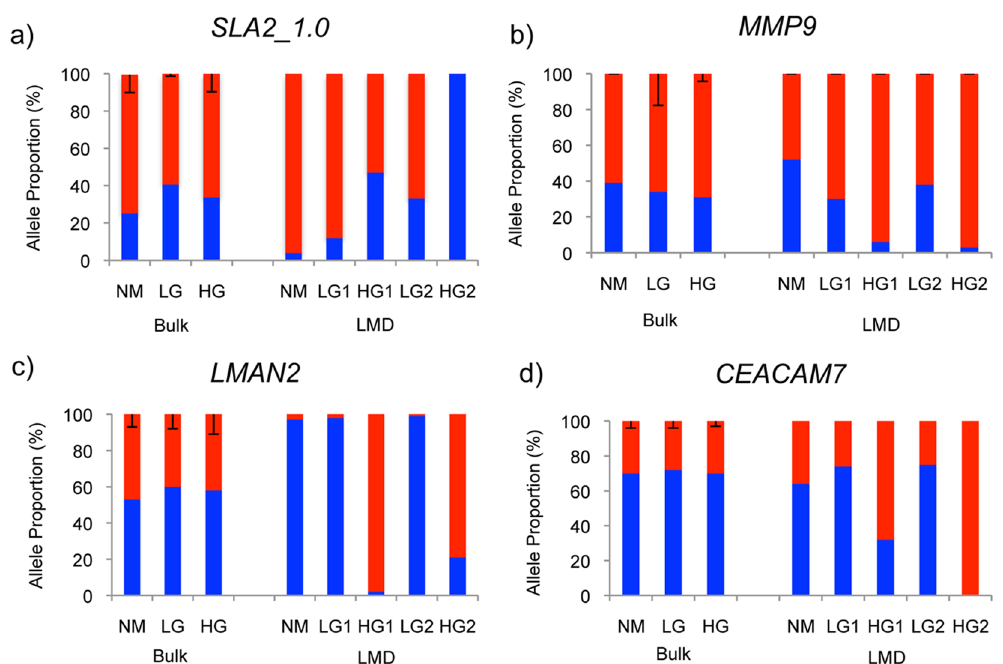
Figure 4. Allele specific expression of selected genes in whole and microdissected samples quantified using pyrosequencing. LG1, LG2, HG1, HG2 represent microdissected adenomas from the same polyp. The following SNPs were analysed: MMP9 - rs341963098A/G; SLA2_1.0 rs337323048A/G; LMAN2 – rs339673049C/T; CEACAM7 – 6:45194986 C/T. All SNP positions are according to the Sscrofa10.2 porcine genome reference